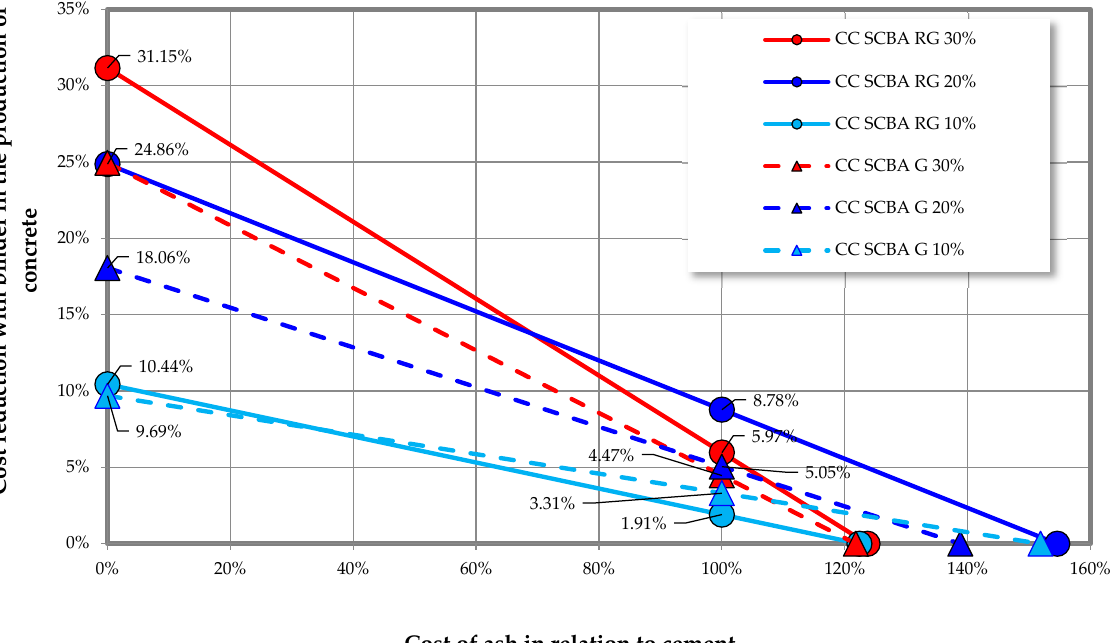
Cost of ash in relation to cement Figure 14. Mortar and concrete cost comparisons for SCBA relative cost variation. For substitutions with re-fired and ground ash, the cost reduction will be 10.44% for concrete with a 10% replacement, 24.86% for 20%, and 31.15% for 30%. For the cost of ash equal to cement (100%), the savings will still be 1.91%, 8.78%, and 5.97% for 10, 20, and 30% of substitutions, respectively. The cost breakeven point will happen when the re-burnt and ground ash value reaches 122.4% of the cement value for 10%, 154.6% for 20%, and 123.7% for the 30% replacement, considering the same compressive strength acquired.